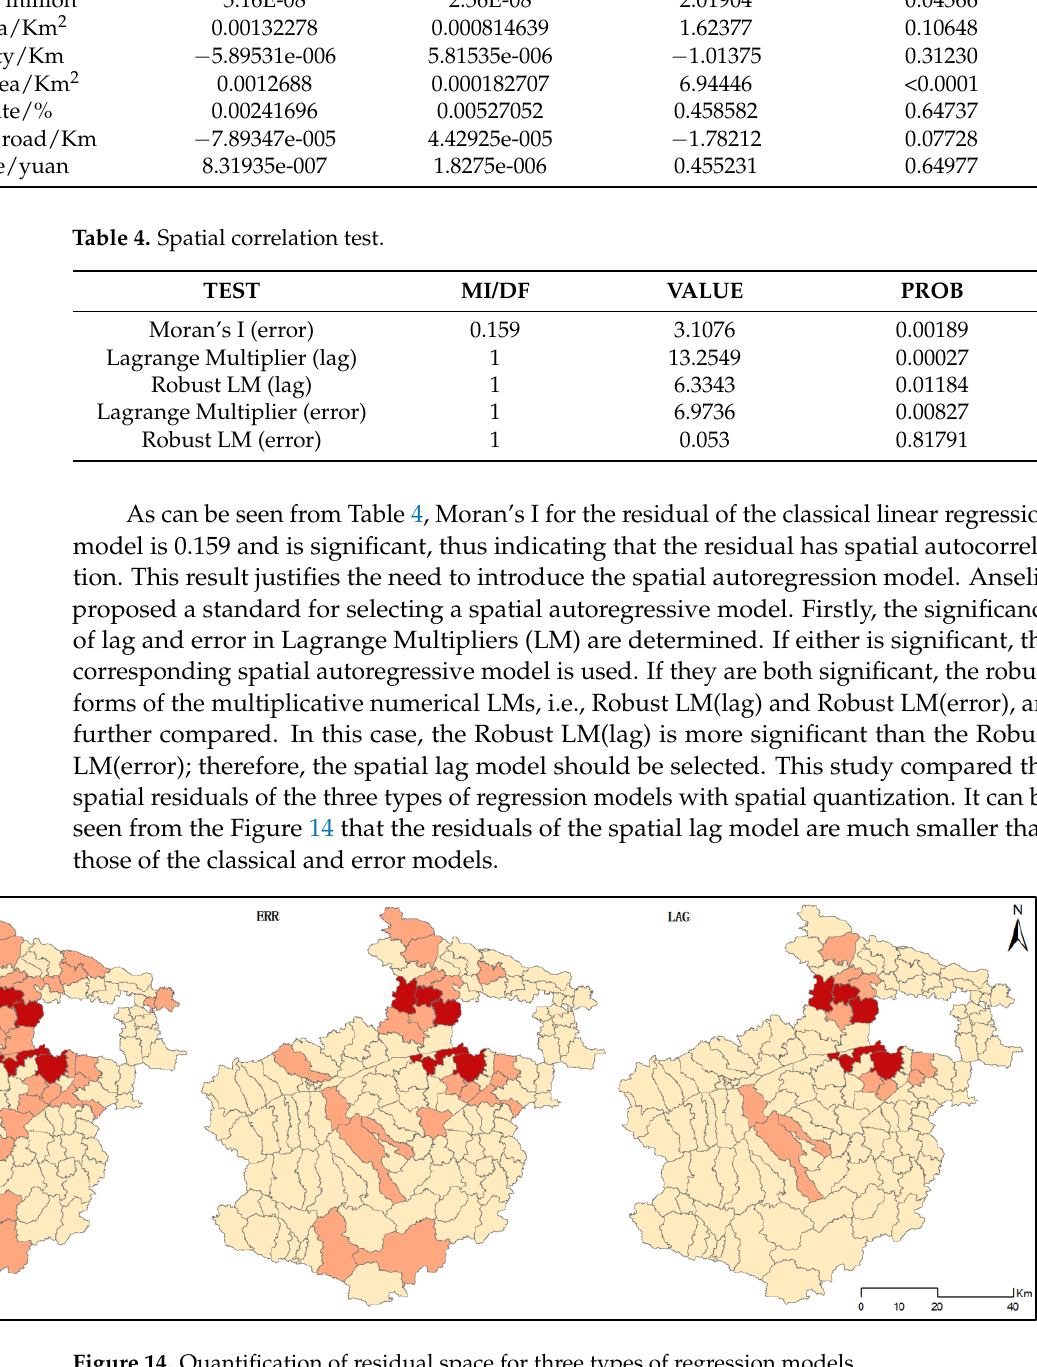
Table 5. Spatial lag model results.